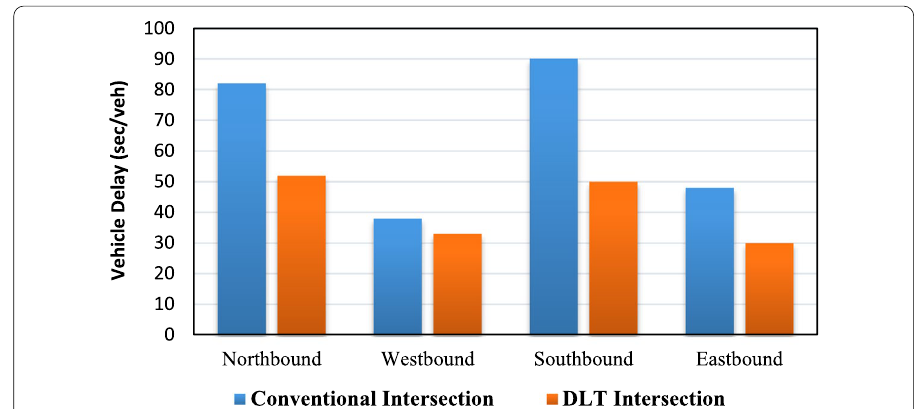
Fig. 7 Simulated results for vehicle delay of conventional and DLT intersections